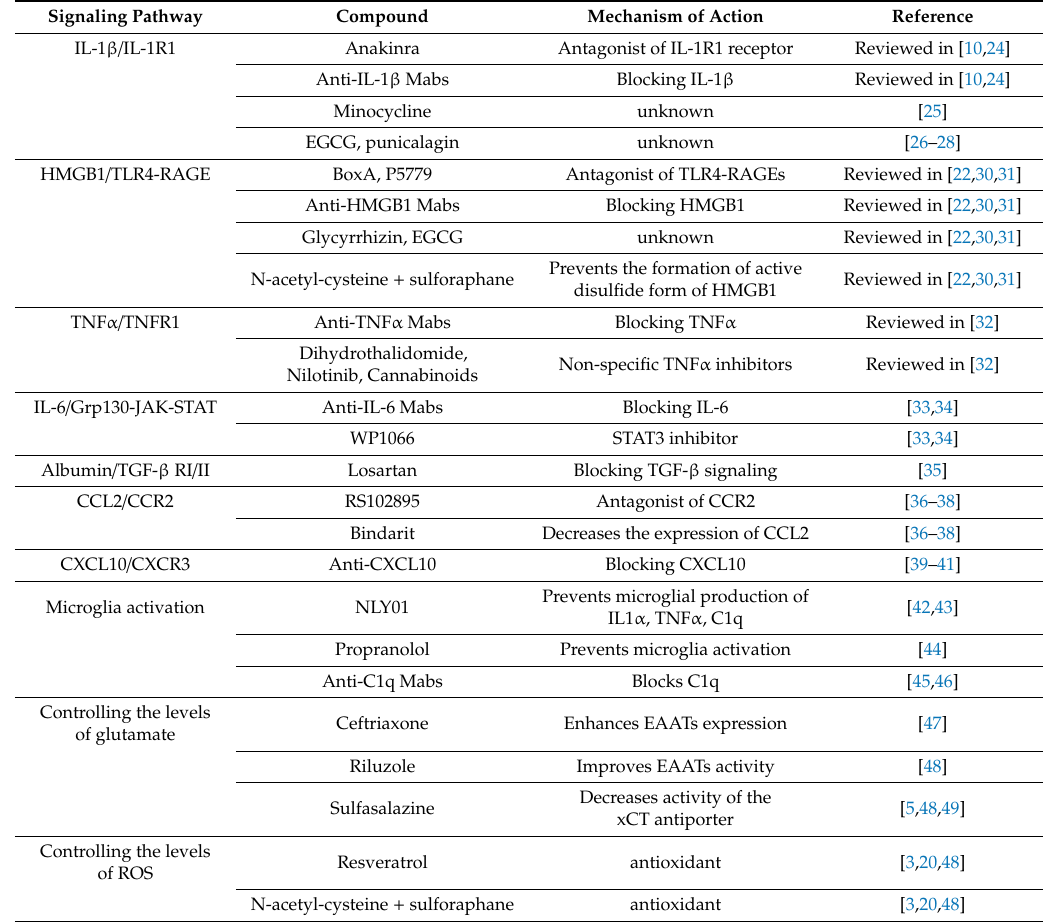
Table 1. Therapeutic opportunities based on ameliorating reactive glia-derived neuroinflammation. Signaling